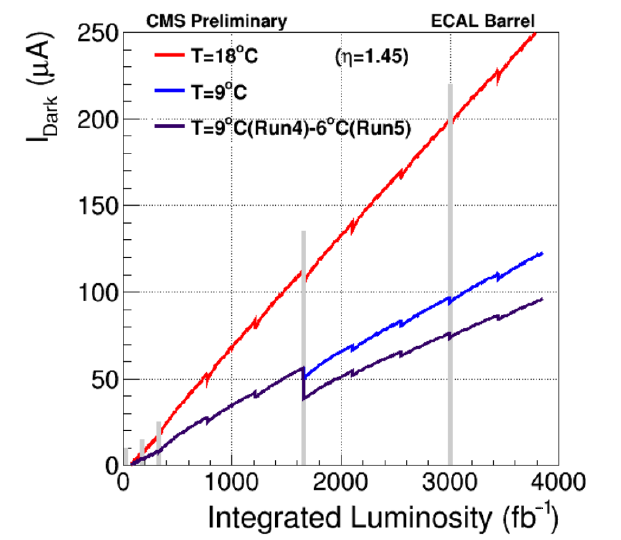
Figure 5. Dark current for different operating conditions. The current for APDs operated at 18 ◦ C is shown in red, while that for APDs at 9 ◦ C is shown in blue. A third possibility is shown in purple, where the APDs are operated at 9 ◦ C in Run 4 (the first data taking period of HL-LHC), with the temperature reduced to 6 ◦ C in Run 5 (the second data taking period of HL-LHC, after a shutdown which allows for experimental upgrades). The vertical shaded lines indicate long shutdowns